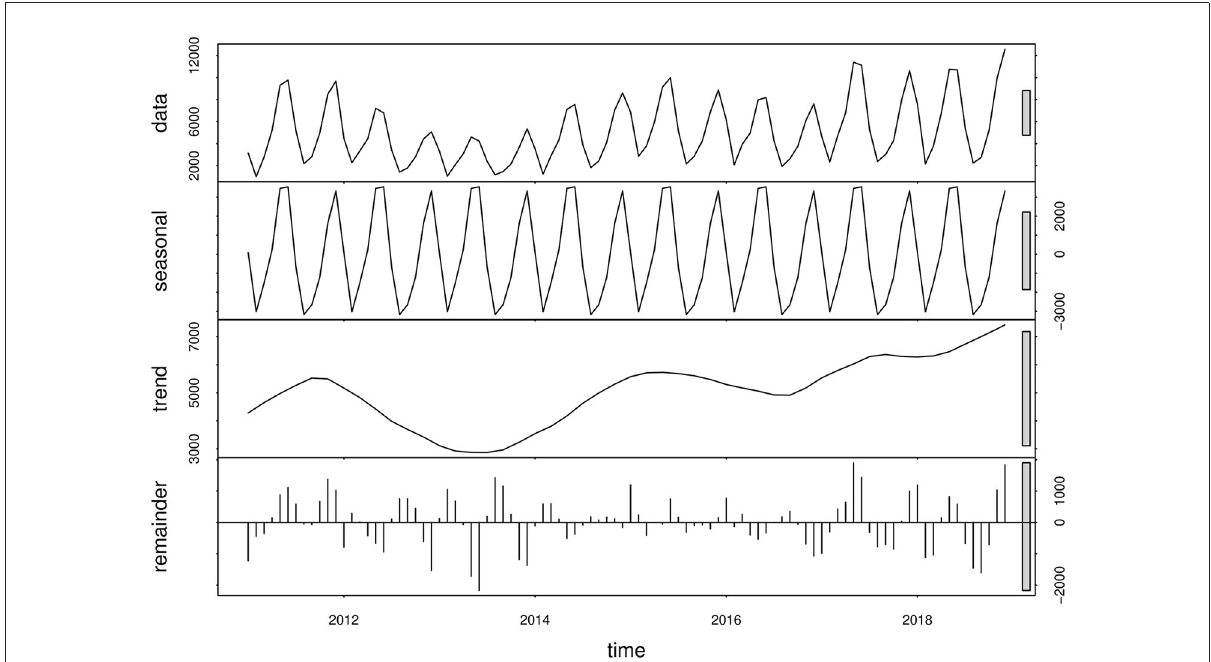
FIGURE3 Monthly scarlet fever incidence and variations, from January 2011 to December 2018.